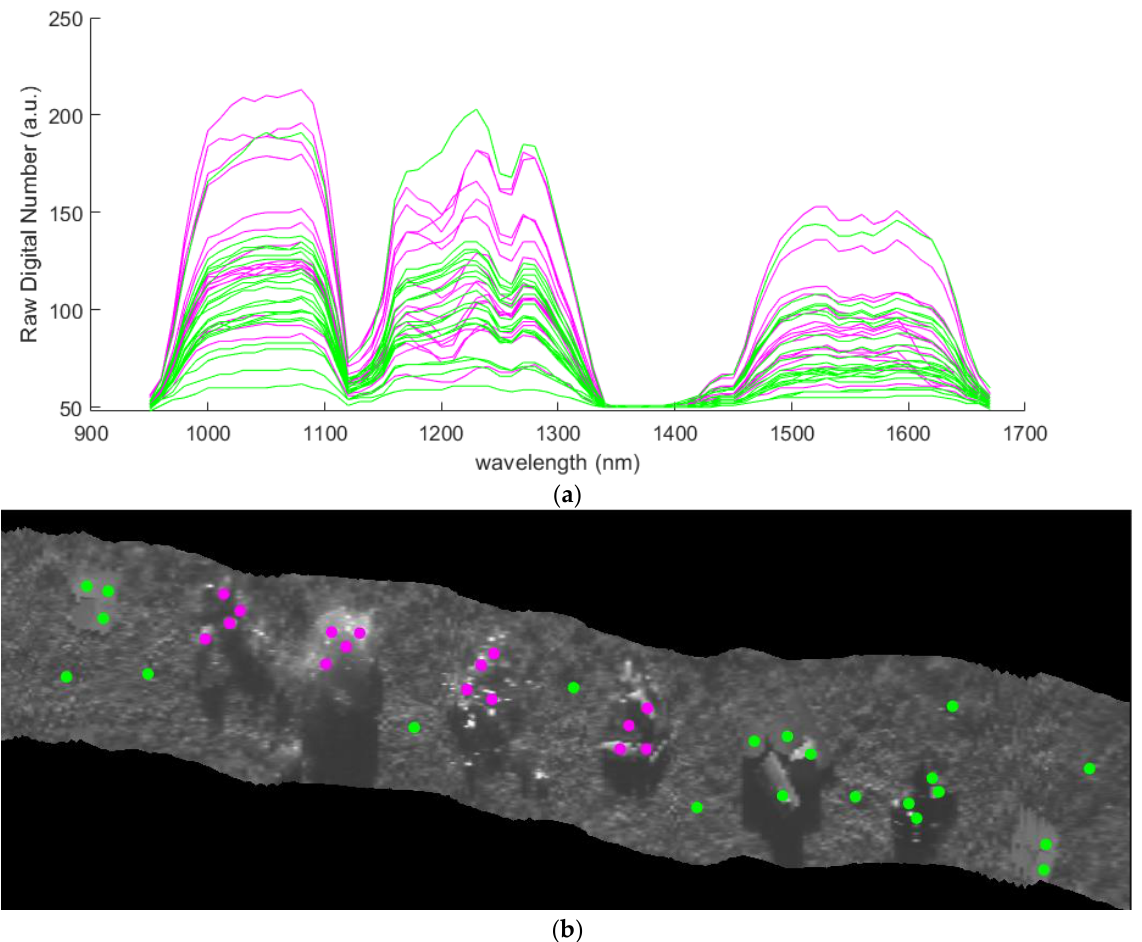
Figure 5. ( a ) Examples of typical raw spectra of pixels corresponding to plastics (magenta), namely PE and PET materials, and non-plastics (green), namely wood, glass, floor tiles, grass-covered ground; ordinates are in Raw Digital Number units, corresponding to the sensor response recorded as 8-bit integers. ( b ) Hyperspectral cube layer for wavelength 1010 nm: superimposed magenta points correspond to plastics spectra of panel ( a ), green points to non-plastics spectra. The pixel width, projected to ground level, at a 10 m distance (the typical distance between sensors and target), is about 7 mm (transversally with respect to the flight direc- tion), for the hyperspectral camera. Even though the same spacing between pixel centers in the directions across and along the flight path is desirable (in order to have the mosaic pixels approximately square), as the drone velocity (about 1 km/h) and the acquisition frequency (16 Hz) are taken into account, a spacing between hyperspectral lines in the flight direction of about 17 mm is obtained, suitable to identify objects a few cm wide. A lower flight speed would lead to an increase in time required for the survey and cause a distortion of the surveyed area due to attitude corrections in presence of wind. The use of a higher-frequency SWIR camera will permit an increase in flight speed, with a conse- quent reduction in the survey duration, while keeping pixels approximately square.